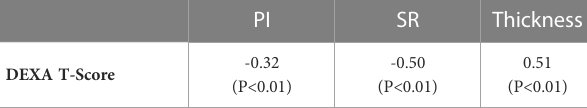
TABLE 3 Spearman ’ s correlation coef fi cients between DEXTA T-score and UTE-based measures (PI, SR, and bone thickness).